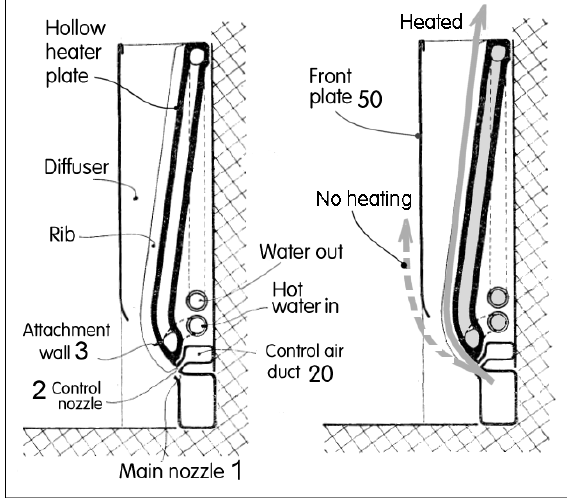
Fig. 13. Induction type window-sill terminal unit with monostable attachment of the jet to the surface of the hollow heater plate (provided with ribs). Numbers refer to components in Figs. 14 and 15.